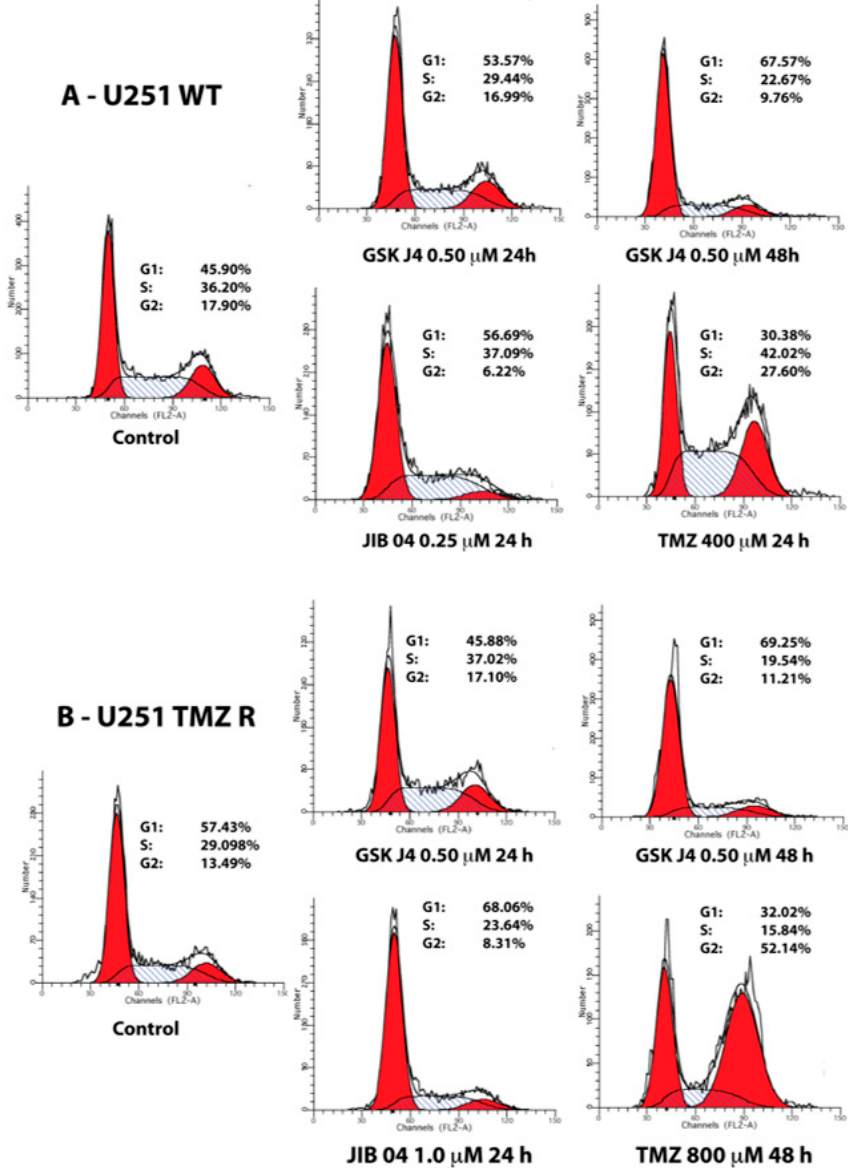
Figure 4. Cell cycle analysis of GB cells treated with TMZ, JIB 04, and GSK J4. The cell cycle distribution of native and TMZ-resistant U251 cells was analyzed by flow cytometry after 24 and 48 h of treatment with the indicated drugs at different concentrations. Representative histogram plots are shown.